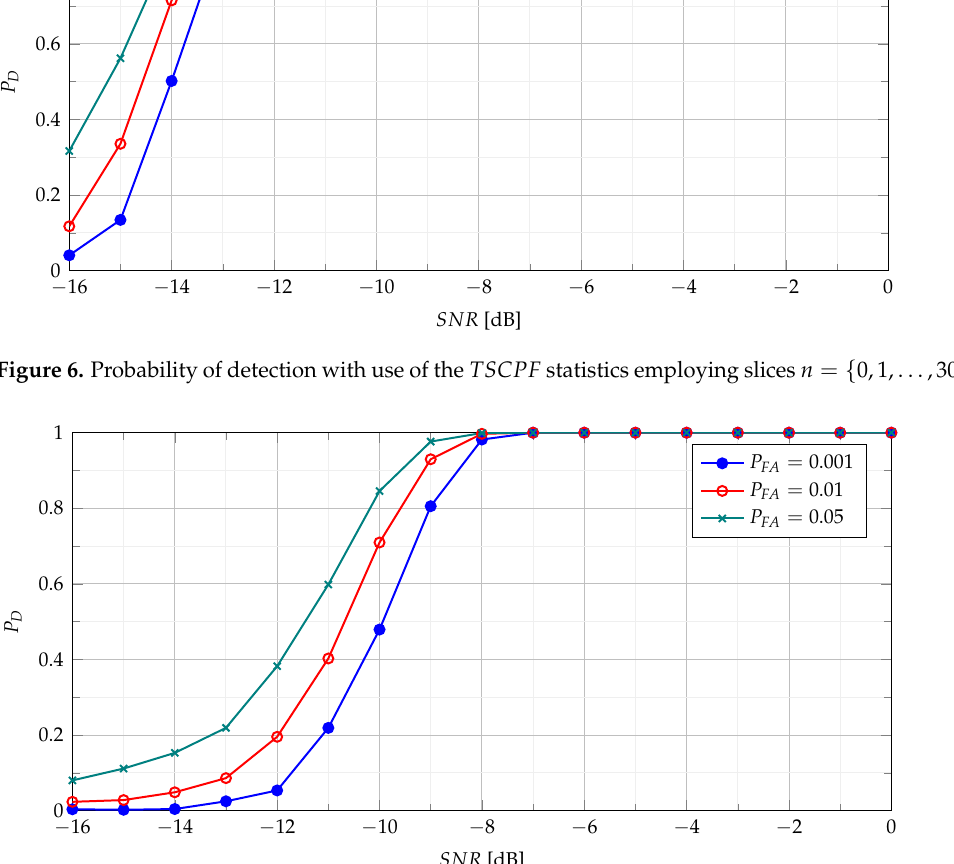
0,1 0,1 . Figure 7. Probability of detection with use of the TPCPF statistics employing slices n = 0,1 . 0,1 . { } { } { } { }